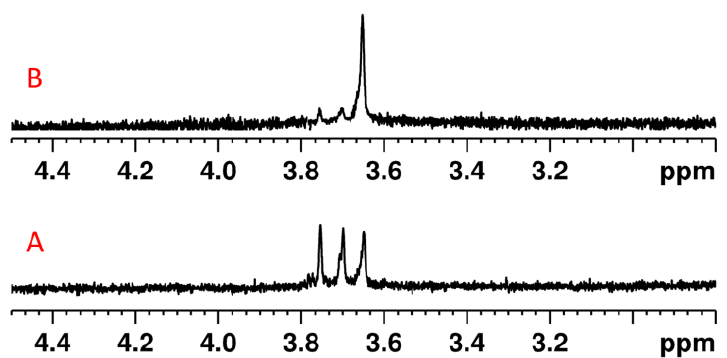
Figure 6. Methoxy region of the 1 H NMR (CDCl 3 , 600 MHz, T = 298 K) spectra of the raw polymer ( A ) and pentane-insoluble ( B ) fraction of the copolymer sample of run 11, Table 2. The 1 H NMR of the sample produced by complex 1 under 30 atm of ethylene (run